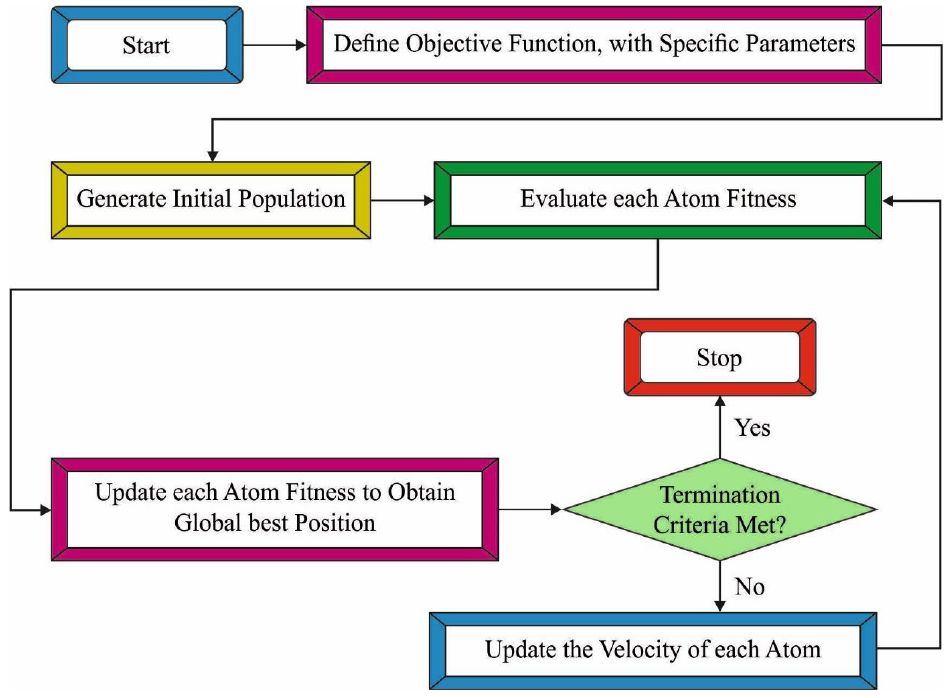
Figure 2. Flowchart of ASO technique.